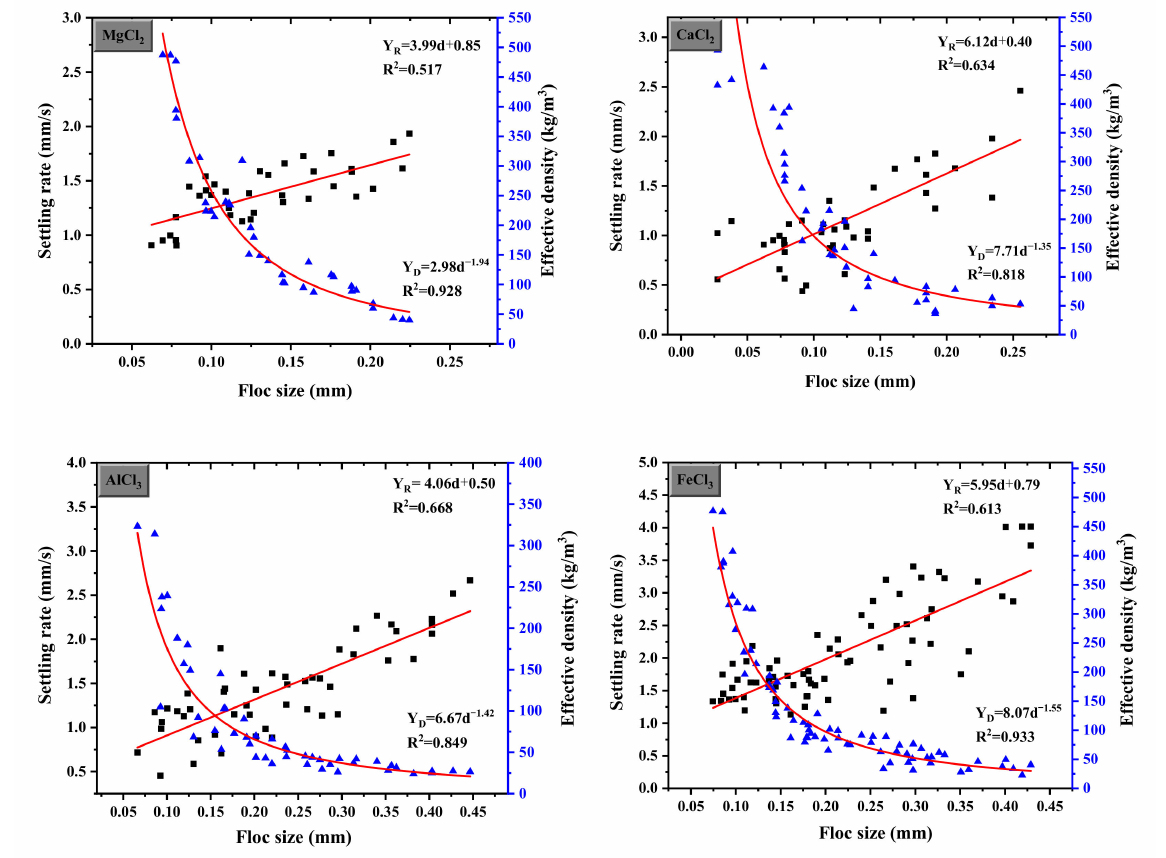
Figure 8. Floc settling rate and effective density as a function of floc size under different